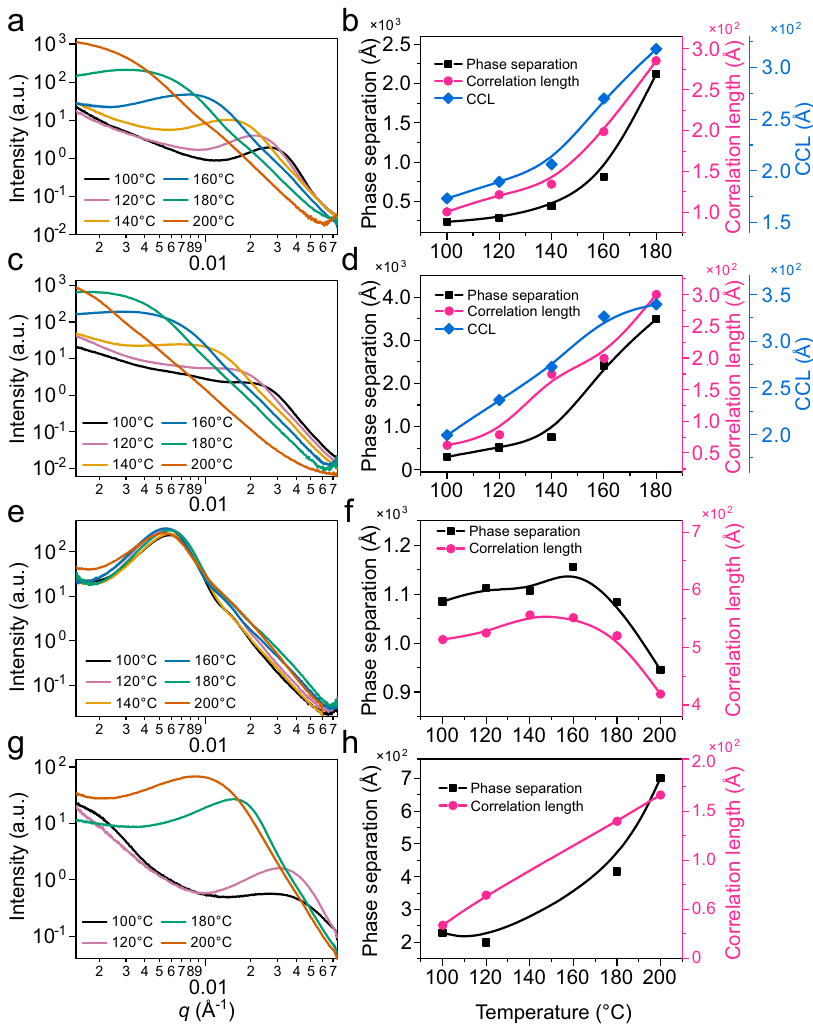
Fig. 4 Ex situ resonant soft X-ray scattering (RSoXS) and relevant morphology parameters. RSoXS pro fi les and morphology parameters summary of a , b DR3TSBDT:PC 71 BM, c , d DTS(PTTh 2 ) 2 :PC 71 BM, e , f DPPEZnP-TEH:PC 61 BM and g , h DPPEZnP-TEH:PC 61 BM/Py under different annealing